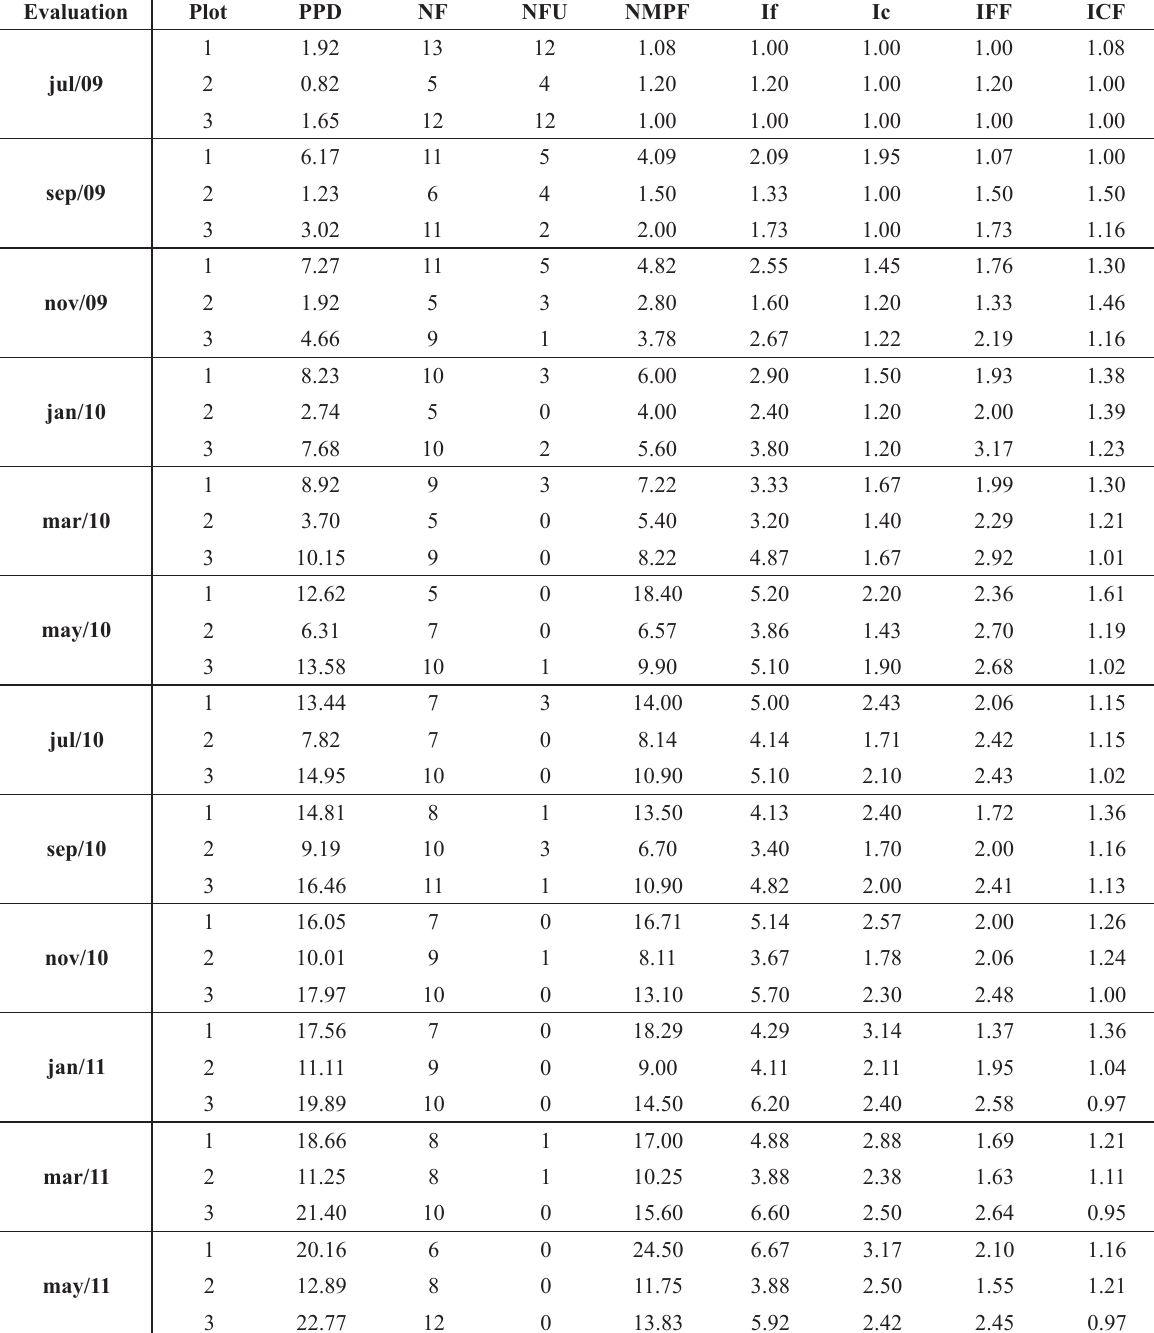
Analysis of dynamics and structure of outbreak sources (ADEF) in three plots of dwarf coconut palms with 729 trees